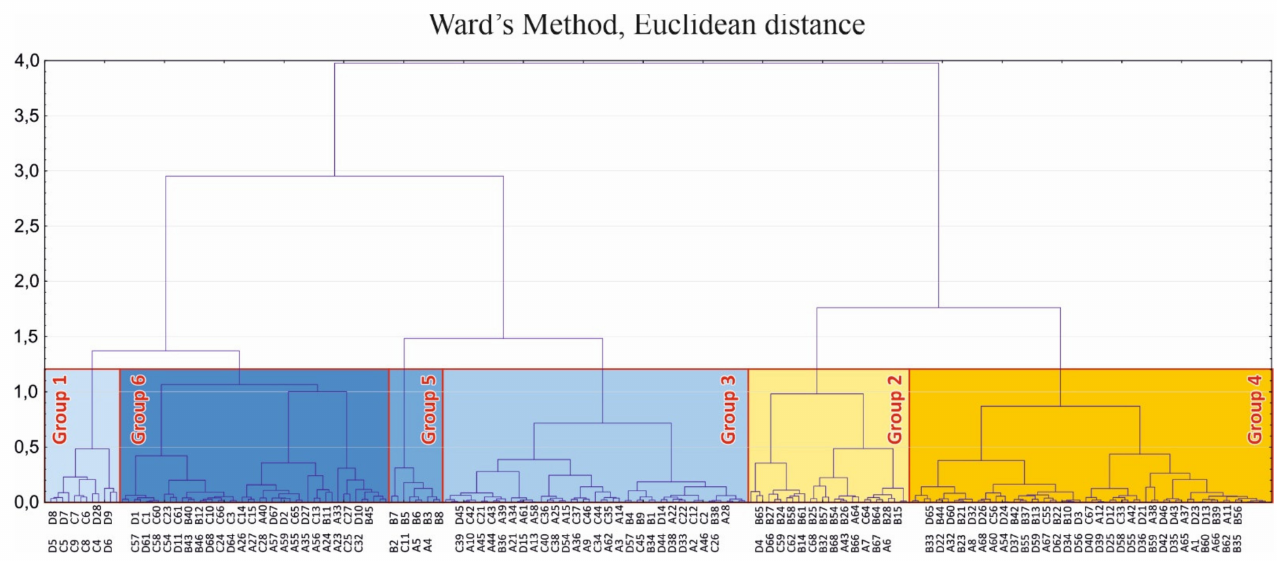
Figure 9. Grouping of differences in land cover in the areas based on a cluster analysis using Ward’s method for all the areas and all the years in question. Identifier format: YB, where Y—year (A—1973–1996, B—1951–1973, C—1938–1951, D—1996–2017), B—basic field number (from 1 to 51).